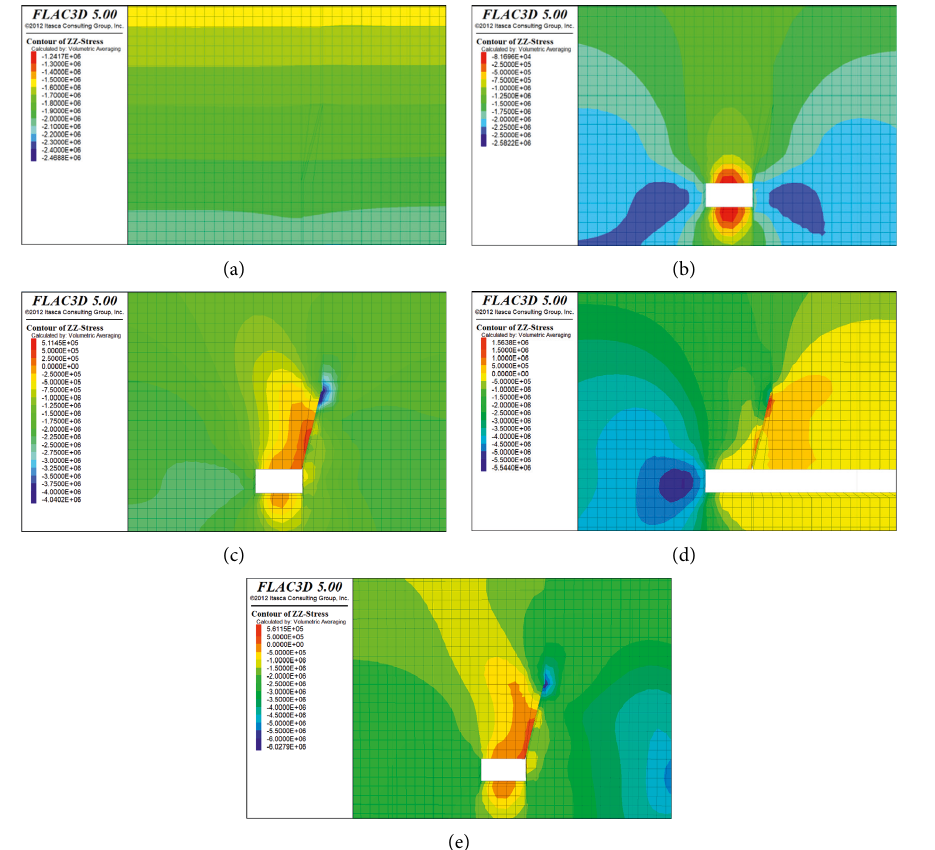
Figure 9: .Simulation results of